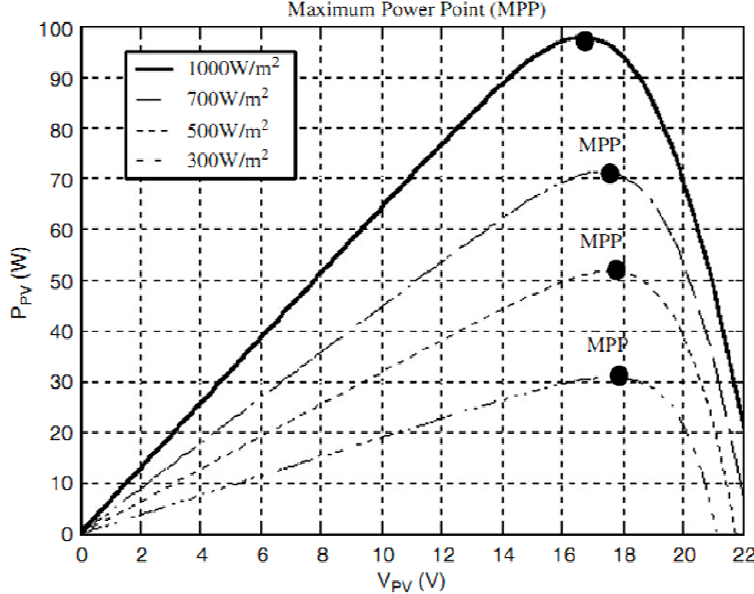
Figure 4. Characteristic curves at four different irradiances.